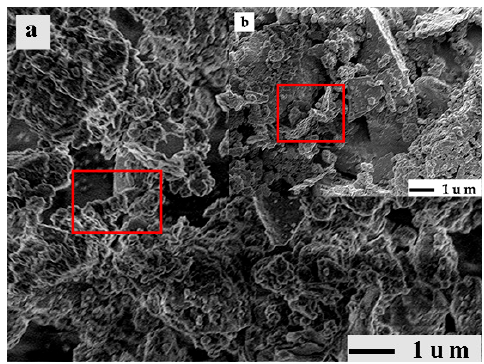
Figure 7. The fibrous gels in RPs: ( a ) RCP, ( b ) RMP.